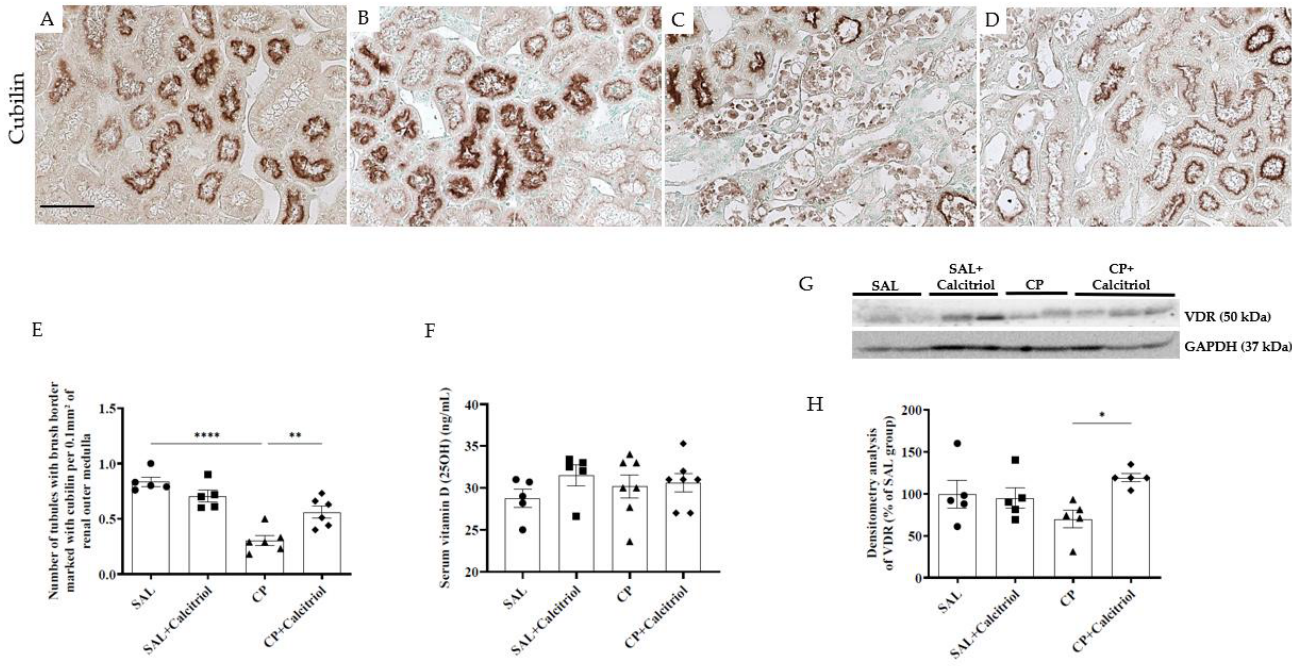
Figure 4. Immunolocalization of cubilin in the renal outer medulla of the SAL ( A ), SAL + calcitriol ( B ), CP ( C ) and CP + calcitriol ( D ) groups (bar indicates 50 µ m). The number of tubules with a brush border marked with cubilin ( E ) from all experimental groups (SAL, SAL + calcitriol, CP, CP + calcitriol). Serum levels of 25(OH) of all experimental groups (SAL, SAL + calcitriol, CP, CP + calcitriol) ( F ). Western blot analysis of vitamin D receptor (VDR) and GAPDH ( G ) in the renal tissue from all experimental groups (SAL, SAL + calcitriol, CP, CP + calcitriol). VDR densitometry ( H ). The densitometric ratio between VDR and GAPDH was calculated, and data are expressed in comparison with the control group, with the mean control value (±SEM) designated as 100% and expressed as mean ± SEM ( n = 5 – 8 for each group). Blots are representative images of independent experiments. * p < 0.05; ** p < 0.01; **** p < 0.0001: magnification, ×400.